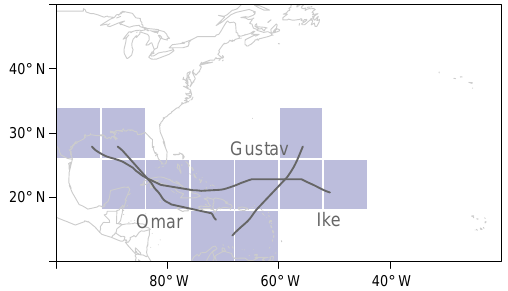
Figure 1. Tracks and corresponding cells for three 2008 hurricanes: Gustav, Ike, and Omar. Each colored cell indicates at least one storm intensifies within its boundaries.